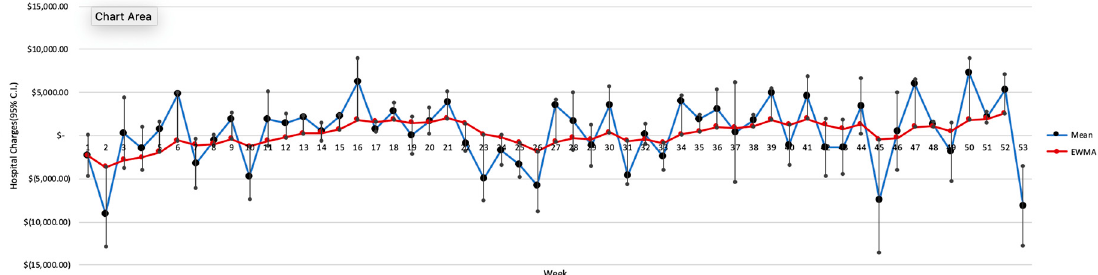
Figure 6. Hospital charges difference of means and 95% CI between correct and incorrect D x ‘s of aneurysm.